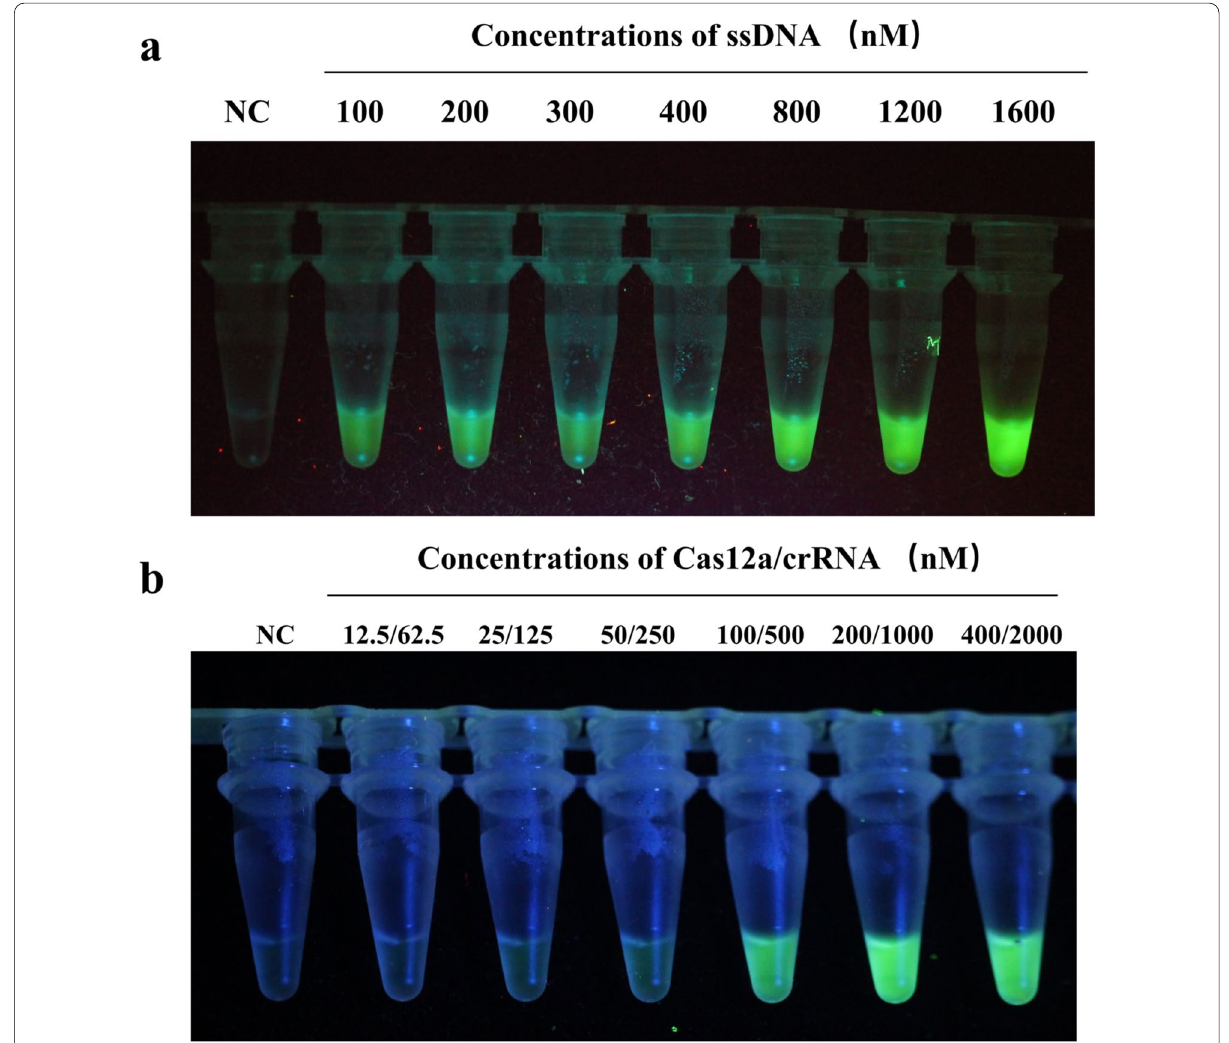
Fig. 2 Optimization of the reaction components and conditions for CRISPR/Cas12a-based visual detection. a Determination of optimal ssDNA concentration by comparison. b Determination of optimal Cas12a/crRNA concentration by visual observation